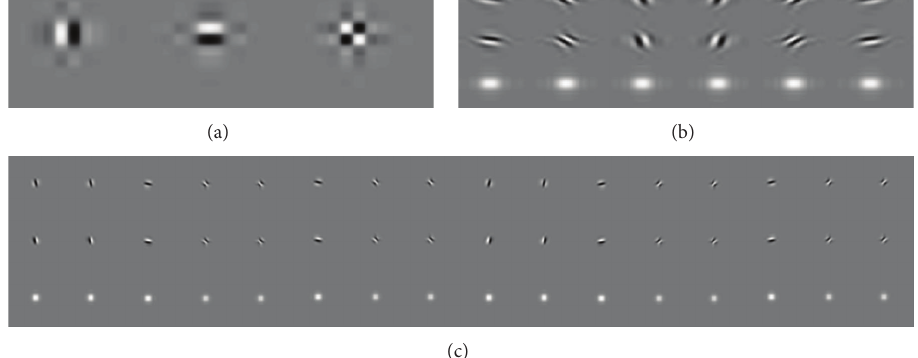
Figure 2: Impulse responses of (a) 2D DWT, (b) 2D DT-CWT, and (c) 2D CDDDT-DWT, as illustrated at level of 4 of the transforms.